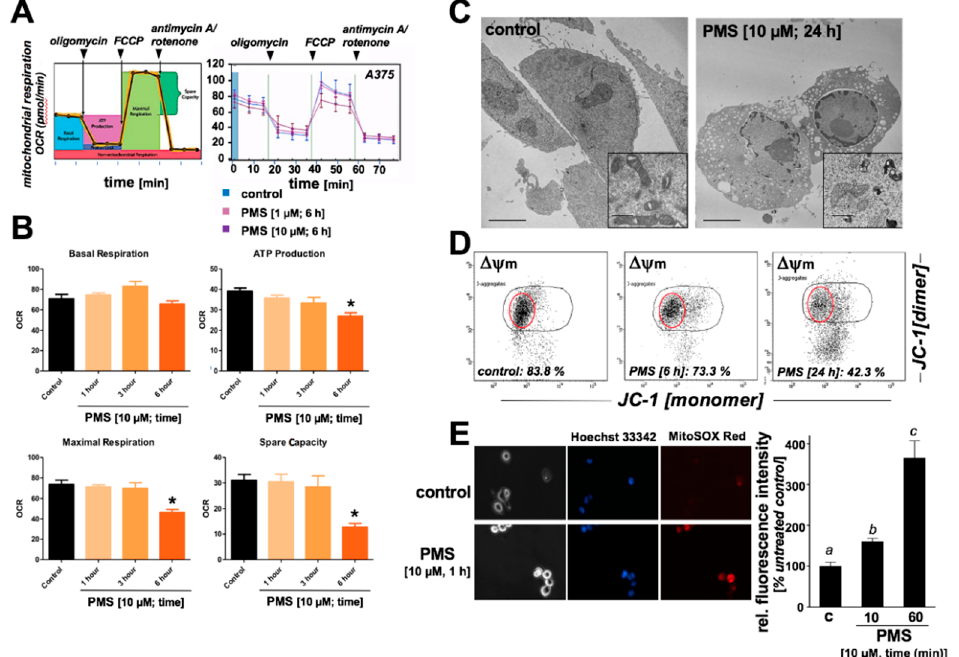
Figure 4. PMS exposure impairs mitochondrial oxygen consumption rate (OCR) and causes loss of mitochondrial transmembrane potential ( Δψ m) with superoxide generation in human A375 malignant melanoma cells. A375 melanoma cells were exposed to PMS, and effects on mitochondrial function were assessed. ( A ) Mitochondrial OCR was monitored using a Seahorse Extracellular Flux (XF) 96 analyzer in real-time in live A375 cells exposed to PMS (1–6 h preincubation time; 1–10 μ M); left panel: general metabolic parameters as assessed by Extracellular Flux analysis; right panel: